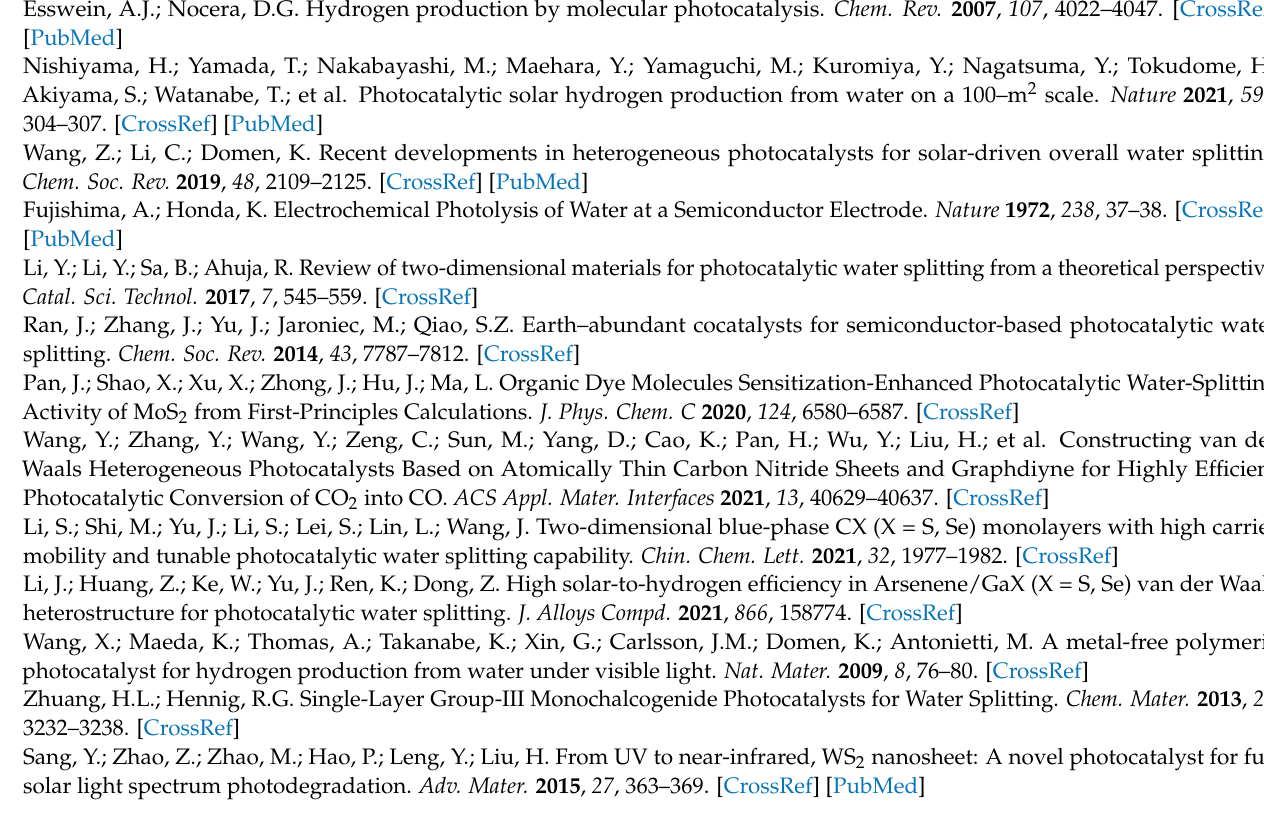
lattice constant of monolayer SiTe; Figure S2: The band structures of monolayer SiTe under strain engineering; Figure S3: The planar average potential of monolayer SiTe under strain engineer- ing; Figure S4: The band alignment of monolayer SiTe under strain engineering; Figure S5: The Absorbance and Absorption edge of 2D polar monolayer